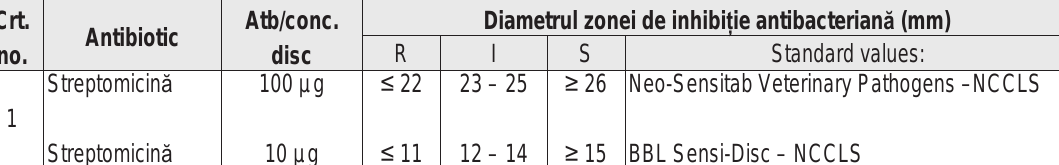
Table1. Disc diffusion test interpretation according to international standards Crt.